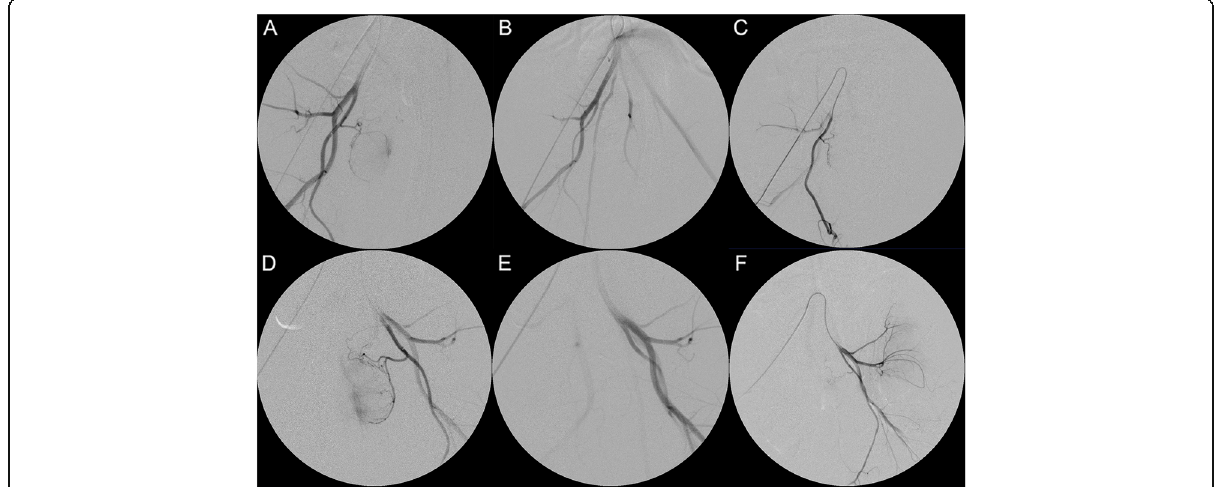
Fig. 3 Selective arteriography before ( a ) and ( d ), immediately after ( b ) and ( e ), and 1 month after PAE ( c ) and ( f ). The images in the upper row are the right prostatic arteriograms; those in the lower row are the left prostatic arteriograms in the same animal. Note occlusion of the prostatic artery in ( b ) and ( e ) and recanalization in ( c ) and ( f ). The right prostatic artery shows total recanalization ( c ) and the left one shows the proximal obstruction with distal fine new vessels ( f